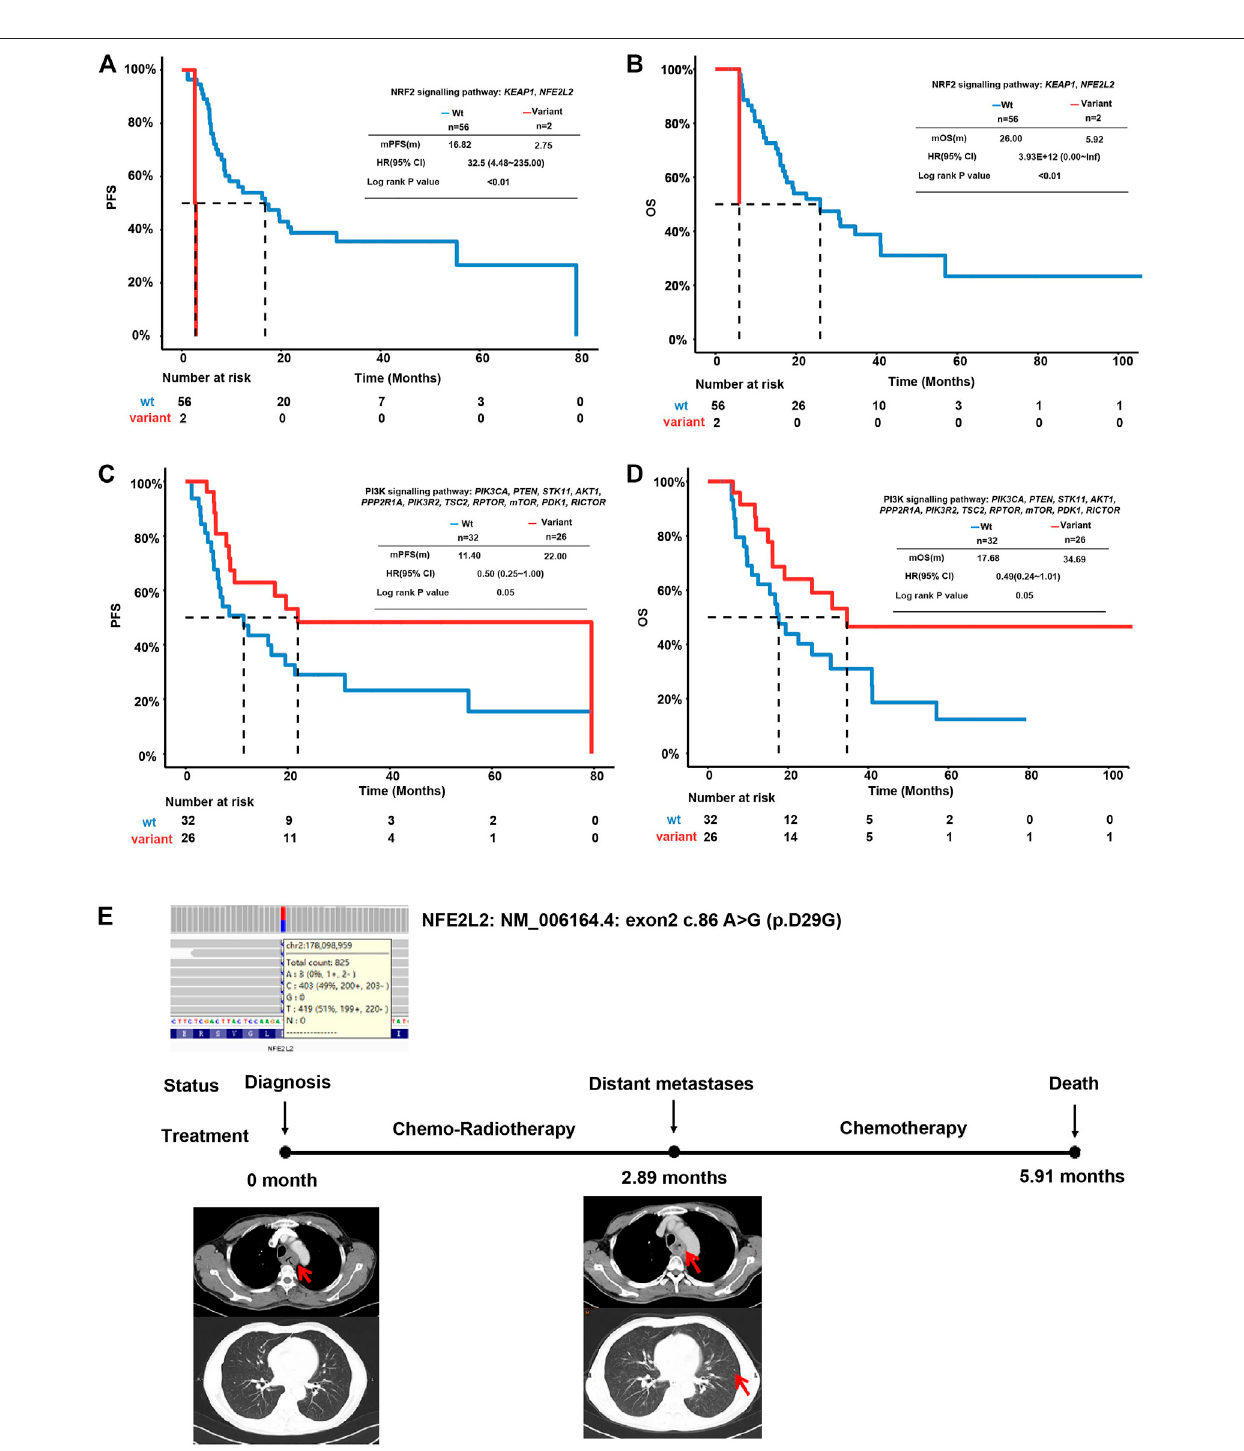
FIGURE 3 | Survival analysis of ESCC patients with altered oncogenic pathways. (A) Kaplan – Meier plot for PFS of ESCC patients with an intact or altered Keap1- Nrf2 pathway. (B) Kaplan – Meier plot for OS of ESCC patients with an intact or altered Keap1-Nrf2 pathway. (C) Kaplan – Meier plot for PFS of ESCC patients with an intact or altered PI3K-Akt pathway. (D) Kaplan – Meier plot for OS of ESCC patients with an intact or altered PI3K-Akt pathway. (E) Representative case of a patient with Keap1-Nrf2 pathway alterations.